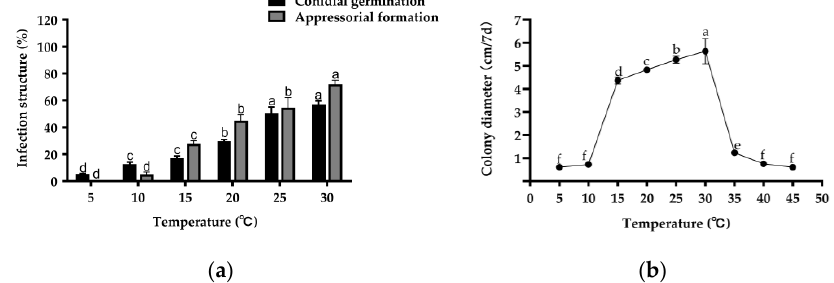
Figure 3. Effect of different temperatures on conidial germination of C. echinochloae, appressorial formation, and mycelial growth. ( a ) Effect of temperature on C. echinochloae B-48 conidial germination and appressorial formation. ( b ) Effect of temperature on C. echinochloae B-48 mycelial growth. The lower-case letter represents significant difference at p < 0.05.